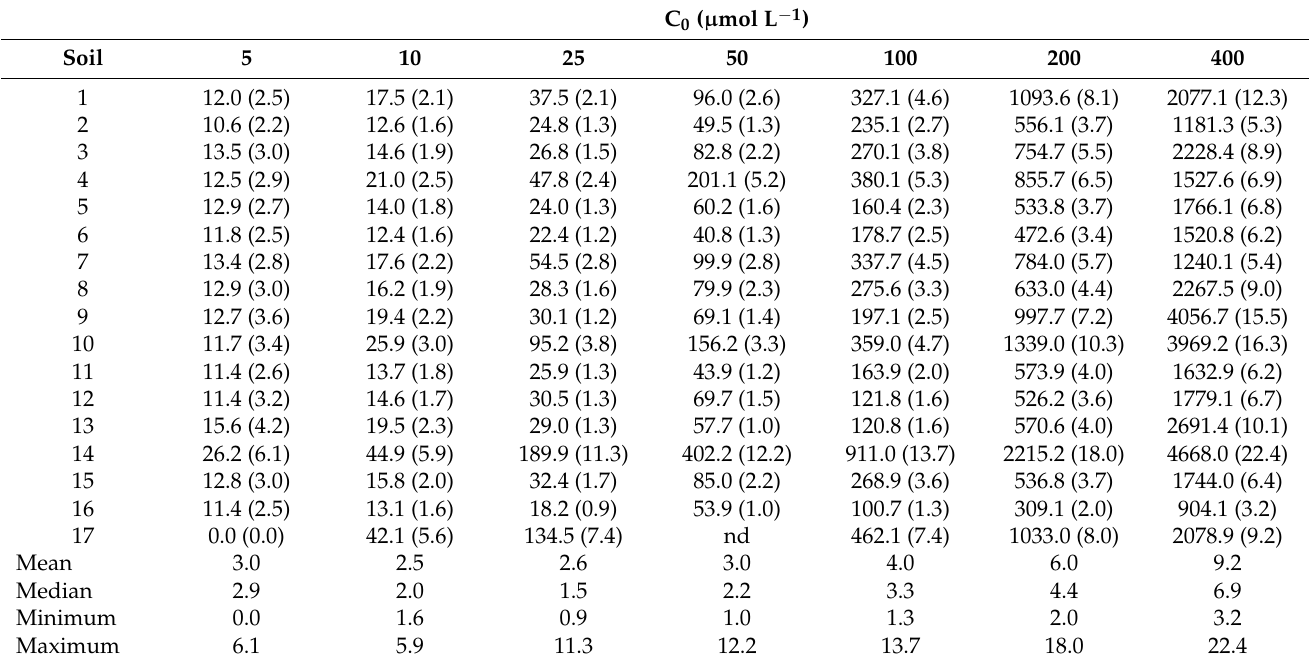
Table 4. Ciprofloxacin (CIP) desorbed in the equilibrium, expressed in µ mol kg − 1 (and in percentage into brackets) for each of the initial concentrations added (C 0 ) and for each of the 17 soils studied. Mean, median, maximum and minimum refer to desorption percentages. nd: not determined.